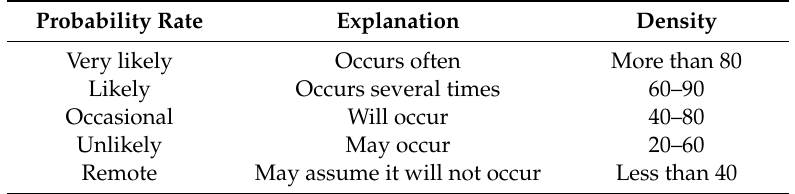
Table 3. The probability categories for the hazard occurrence.